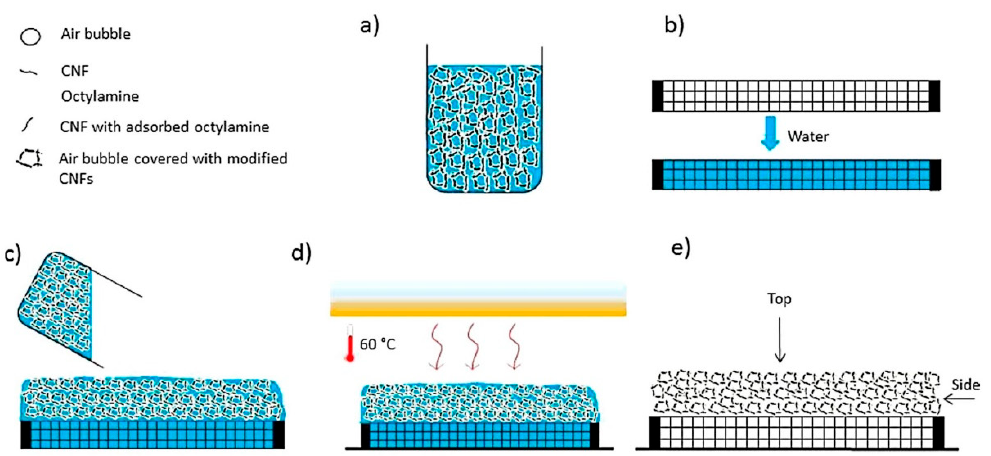
Figure 3. Schematic illustration of the process of the nanofibrillated cellulose (NFC)-stabilized solid foams: ( a ) NFC suspension with a content of 1 wt%, ( b ) dry porous ceramic frit, ( c ) wet foam on top of ceramic frit, ( d ) oven drying at 60 °C, ( e ) solid foam after drying. (Adapted from Cervin and Johansson [28] with permission from Acs Appl Mater Interfaces).